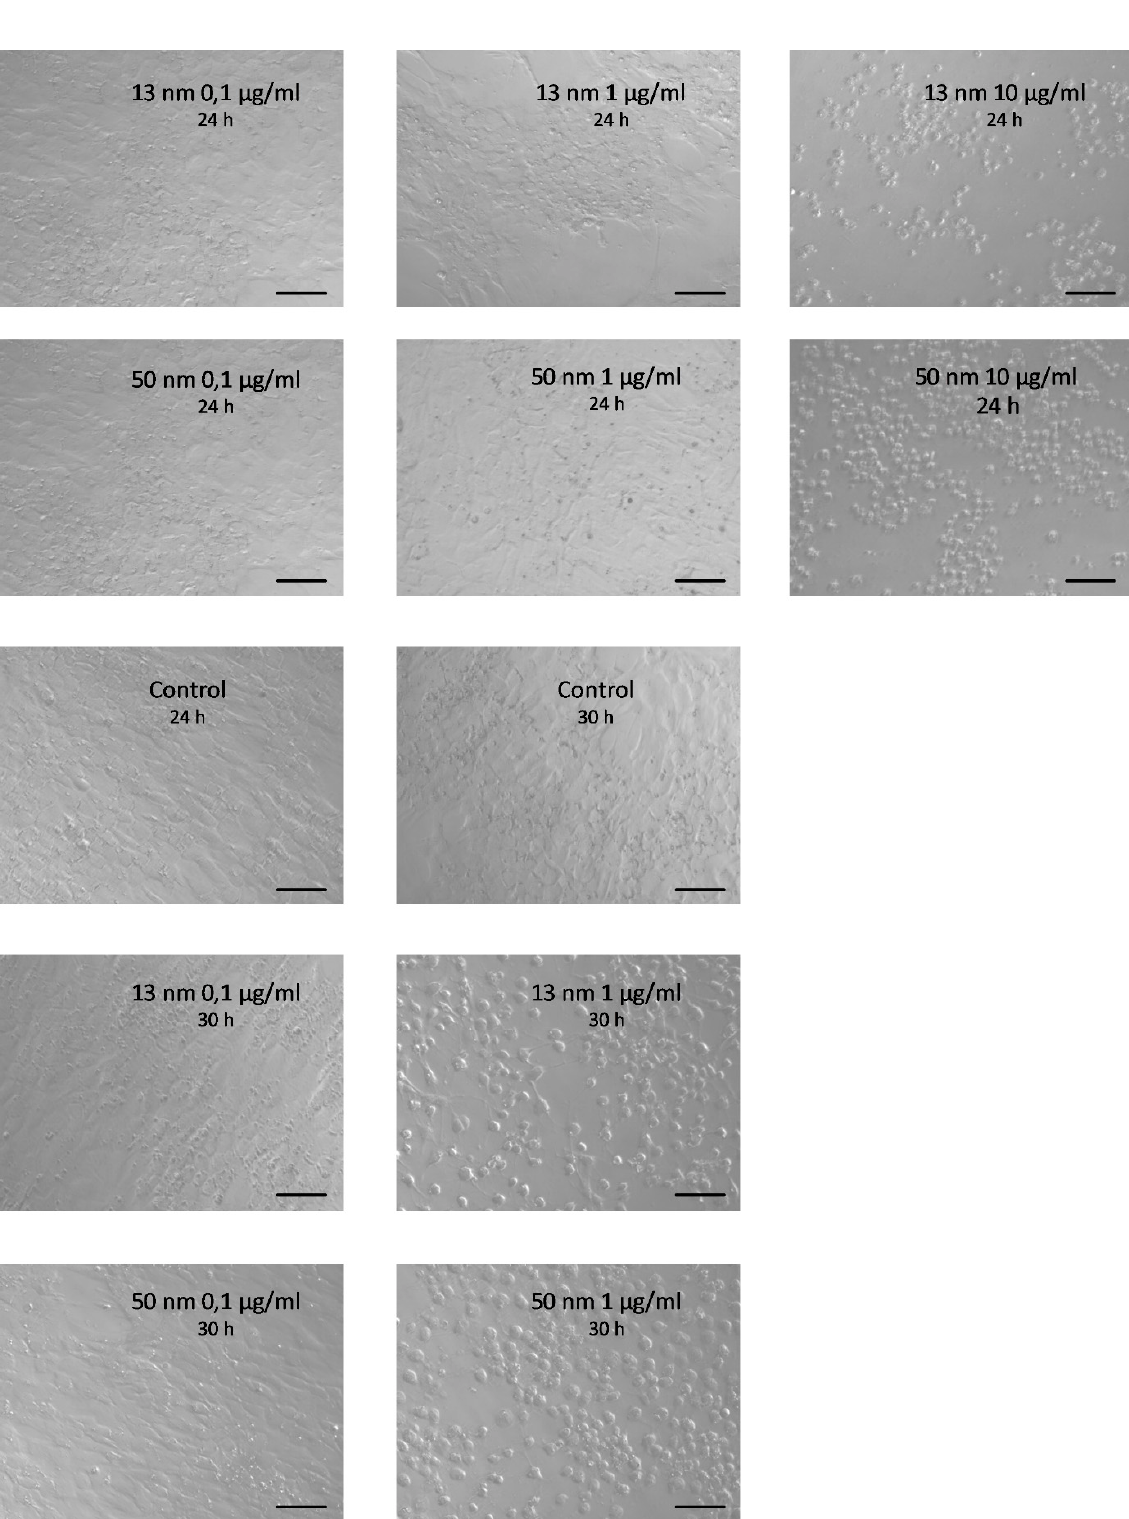
Figure 2. Representative phase-contrast micrographs (taken with an Axio Observer from Zeiss, Germany) showing chicken granulosa cell culture derived from F2 preovulatory follicles with the addition of increased concentrations of 13 nm and 50 nm AgNPs taken after 24 h and 30 h of the incubation period. For better visualization of the difference between 1 µg/ml 13 nm AgNPs and 1 µg/ml 50 nm AgNPs after 30 h of incubation, see Supplementary materials. Scale bars = 50 µm.